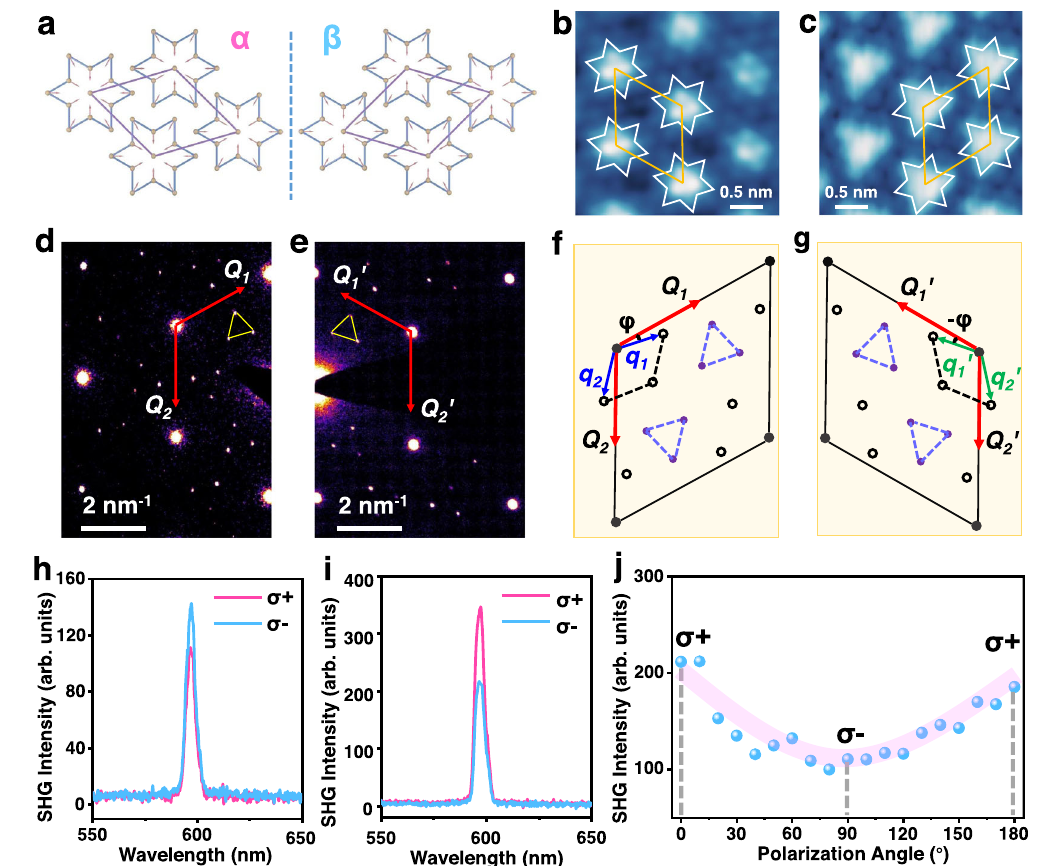
Fig. 2 | Characterization of the chiral structure of 1T-TaS 2 . a Schematics of the twoenantiomers( α and β )fortheCDWsuperlatticestructure. b , c TheSTMimages ofchiralCDWcorrespondingto α and β phases.Thewhitestarandyellowrhombus illustrate the David star structure and unit cell of the superlattice, respectively. d , e SAED results of two 1T-TaS 2 samples with opposite chiral Ramanresponse. Q 1 , Q 2 (or Q 0 1 , Q 0 2 )representthereciprocalvectorsoftheatomiclattice.Thediffraction spots in the triangular groups are from the CDW superlattice. f , g Schematic